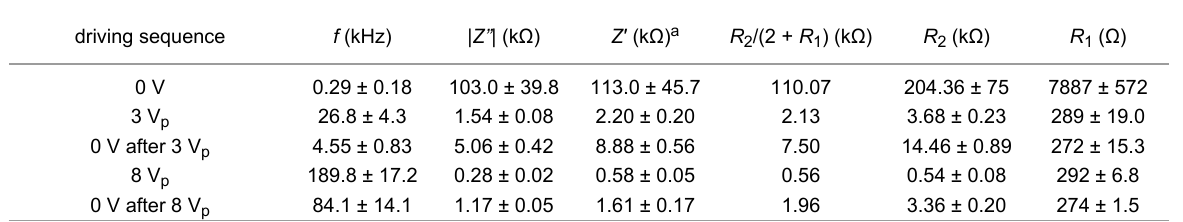
Table 1: Peak values of Z " and comparison of Z ' values with computed R 1 , R 2 (average of three batches). driving